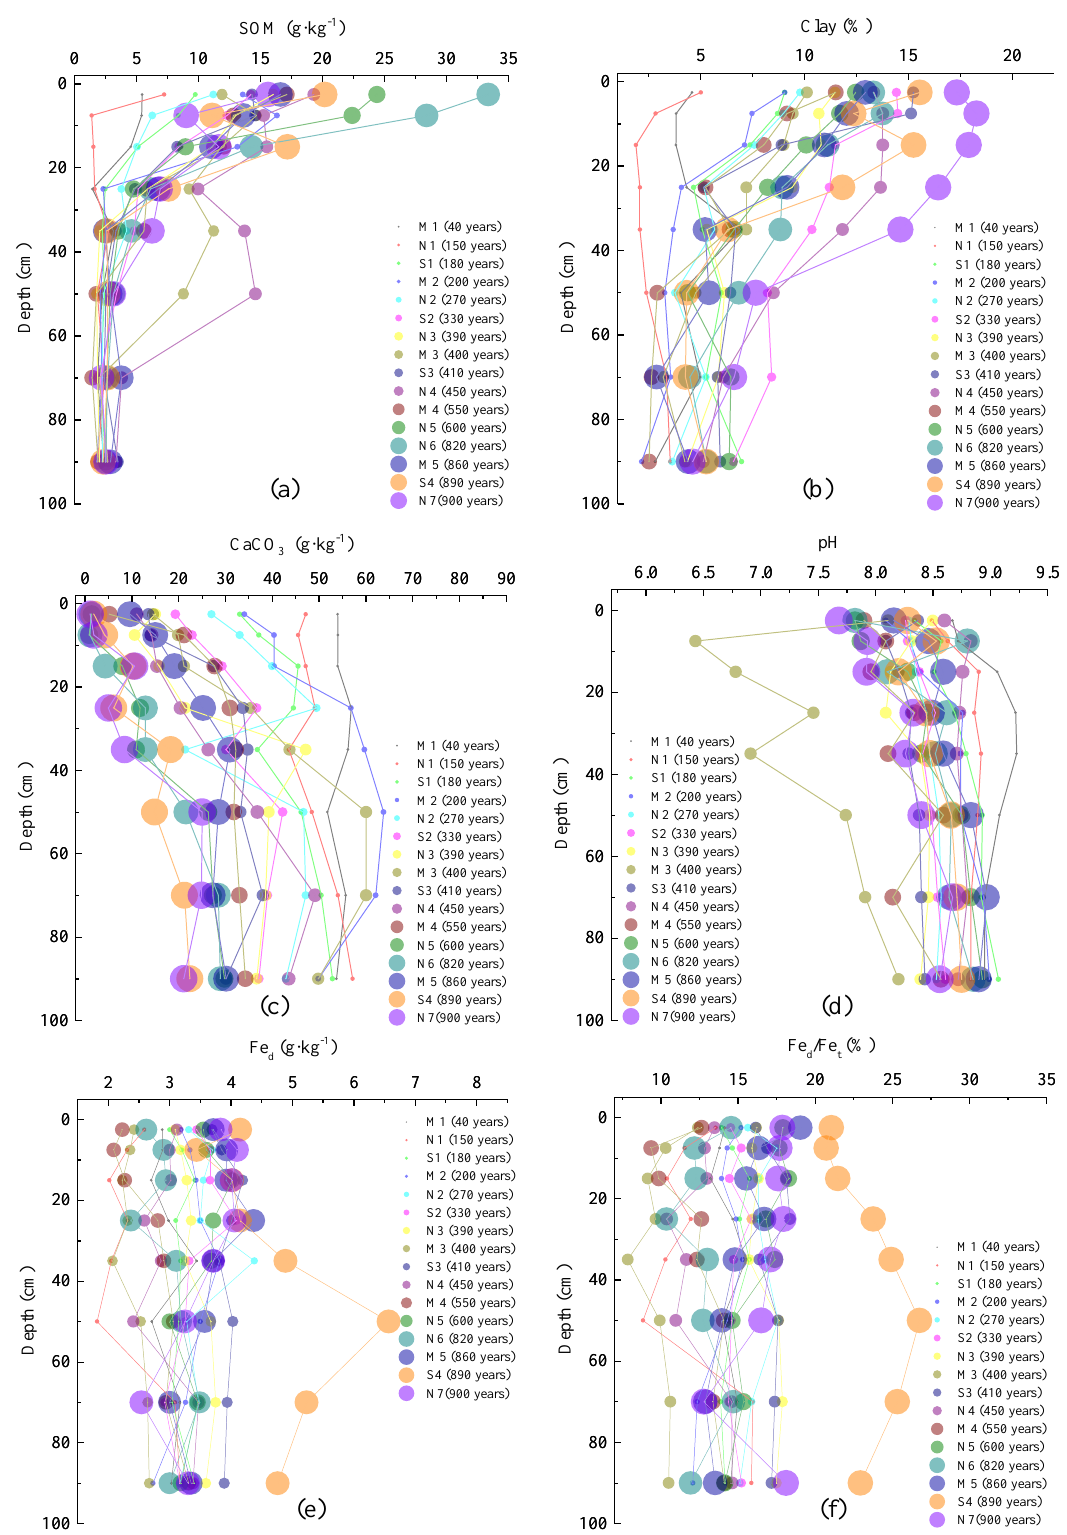
Figure 5. Depth distribution of soil properties depending on the age of soil profiles: ( a ) soil organic matter (SOM); ( b ) clay; ( c ) CaCO 3 ; ( d ) pH; ( e ) Fe d ; ( f ) Fe d /Fe t .